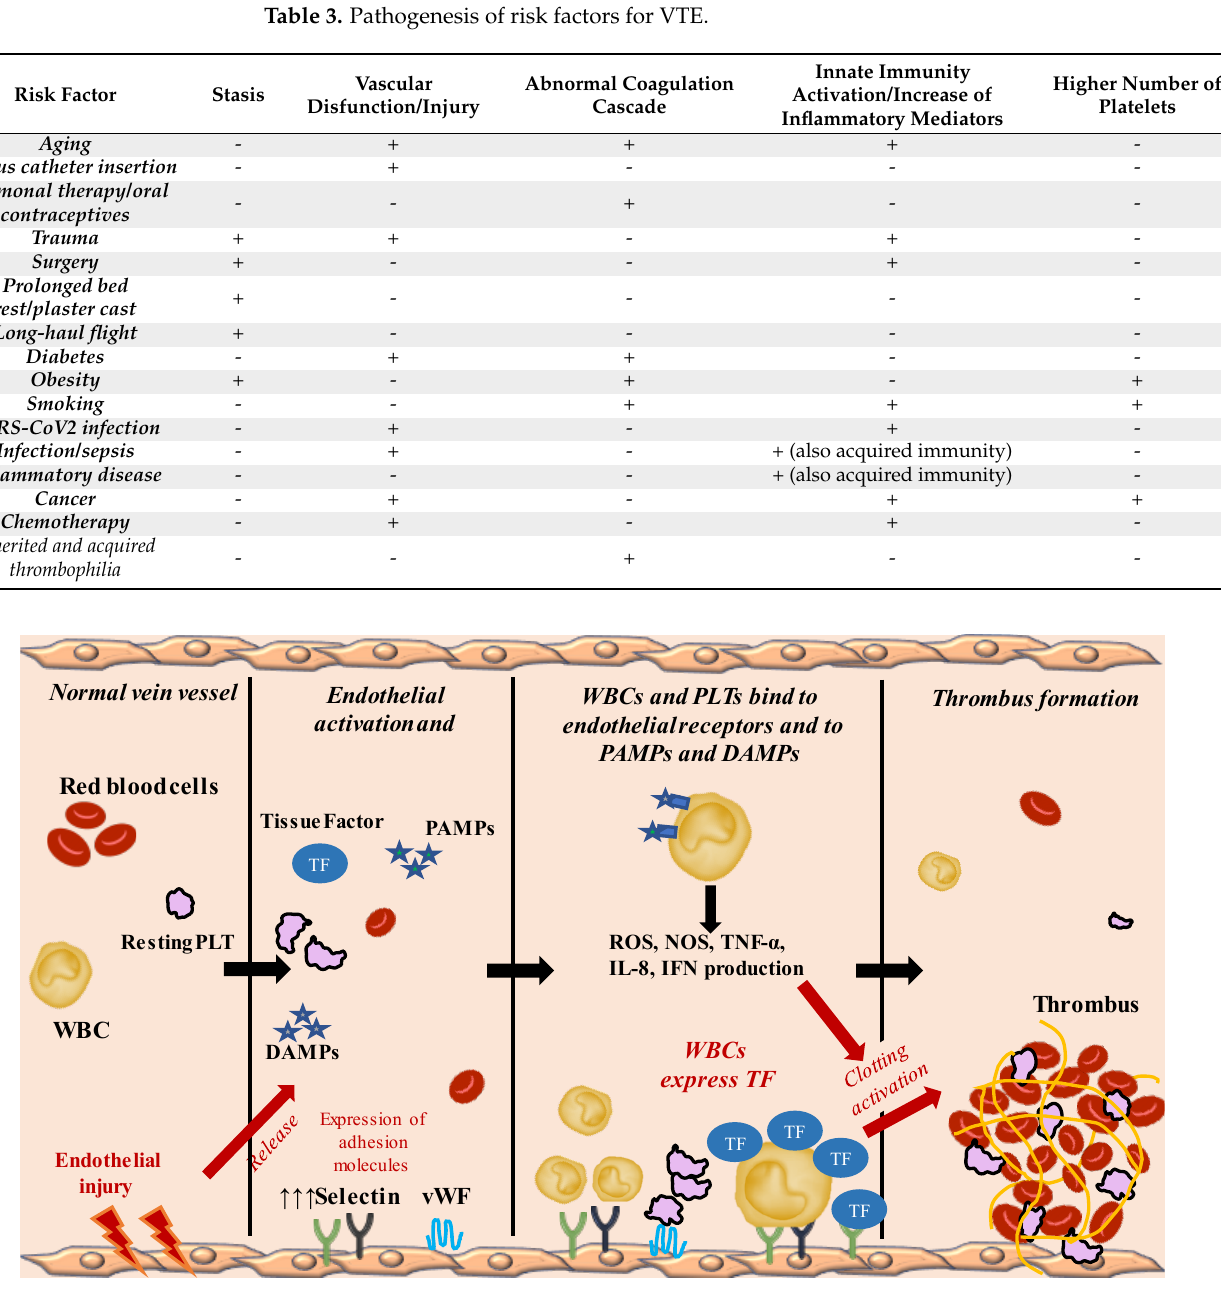
Figure 1. Summary of general mechanisms of venous thrombosis. Afterwards, PLTs and white blood cells (WBCs) bind vWF and P- and E- selectin, and WBCs start expressing TF, triggering coagulation cascade activation [21,22]. In addition, among WBCs, polymorphonuclear neutrophils (PMNs) release neutrophil extracel- lular traps (NETs). These are constituted by extracellular desoxyribonucleic acid (DNA), histones and neutrophil antimicrobial proteins and may contribute as a scaffold to throm- bus formation [21,32], inducing platelets adhesion and activation and maintaining the thrombus stability like fibrinogen and von Willebrand factor [33]. Several factors modulate PLT activation, such as injury and inflammation [34]; in- deed, PLTs express intracellular and membrane toll-like receptors (TLRs) that bind Dam- age-Associated Molecular Patterns (DAMPs) and Pathogen Associated Molecular Pat- terns (PAMPs), resulting in PLTs activation. PAMPs and DAMPs are also recognized by TLRs expressed by various immune cells [35 – 37]. After binding PAMPs and DAMPs, im- mune cells generate reactive oxygen (ROS) and nitrogen species (NOS), and produce cy- tokines, such as tumou r necrosis factor α, interleukin 8 and interferon (Figure 1) [37,38]. Therefore, the binding of platelets to vWF and WBCs to P-selectin and E-selectin lead, on the one hand, to platelet activation and aggregation and, on the other, to the release of TF. In particular, the increased production of TF leads to the activation of the extrinsic pathway of coagulation, with final formation of fibrin and entrapment of red blood cells and PLTs, resulting in a red-blood-cells-rich thrombus formation [22,27]. 3. Risk Factors for Venous Thromboembolism 3.1. Male Sex Growing evidence suggests that male sex represents a risk factor for VTE. In a work performed by Baglin et al., VTE recurrence after a first unprovoked event was 25.7% in men and 11.7% in women after 2 years follow-up [39]. A similar difference was observed by Kyrle et al., who registered recurrence rates of 20% and 6%, respectively, at 26 months follow-up, with an age-adjusted RR of 3.6 for male sex [40]. At 5 years, the likelihood of recurrence was 30.7 percent among men, as compared with 8.5 percent among women ( p < 0.001) [40]. Data from the PROLONG study showed how VTE recurrence was higher in men than women (7.4% vs. 4.3% patient-years, Hazard Ratio [HR]: 1.7, p = 0.027) [41].